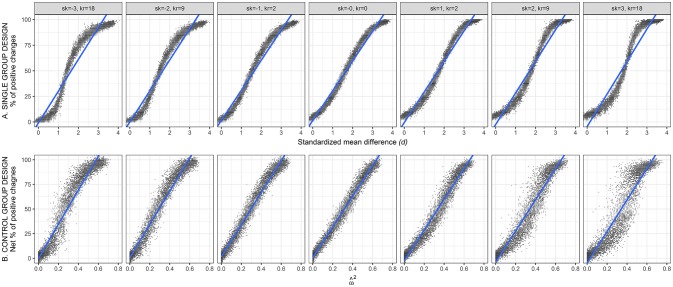
Relation between average-based change (horizontal axis) and individual-based change (vertical axis). Top row (A) shows the data for the simple group pre-post design. Bottom row (B) shows the data for the pre-post design with a control group. Data based on SID with n = 100 and ρpre−post = 0.7. Sk, skewness; Kr, Kurtosis.